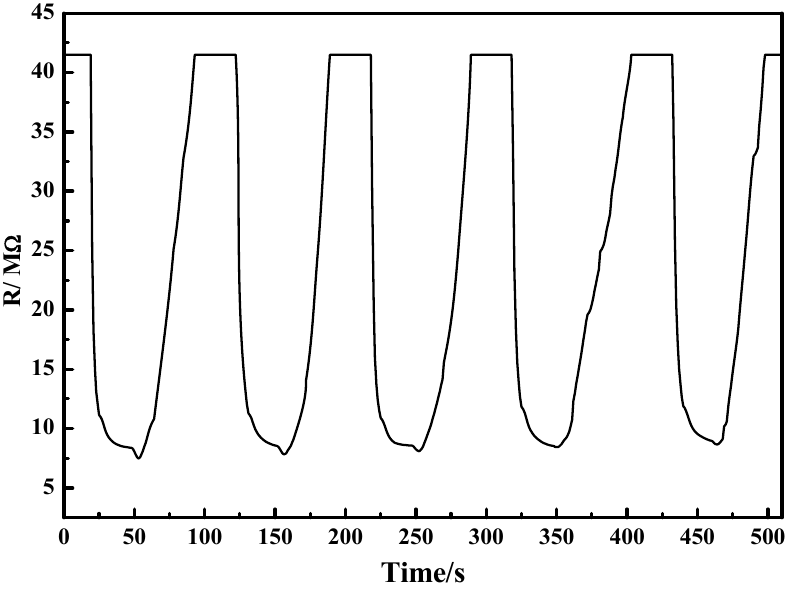
Figure 13. Evidence of reproducible response of the ZnO thick film to 11,000 ppm ammonia at room temperature (23